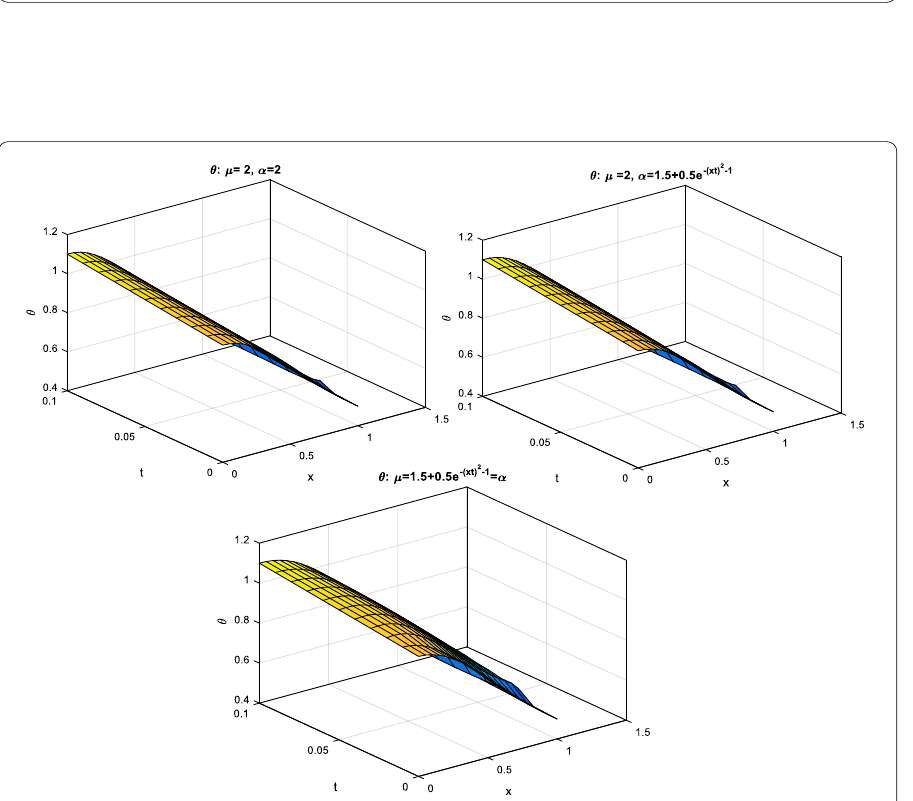
Figure 11 Comparison of the numerical solutions using the introduced method in Example 3 for various values of μ ,